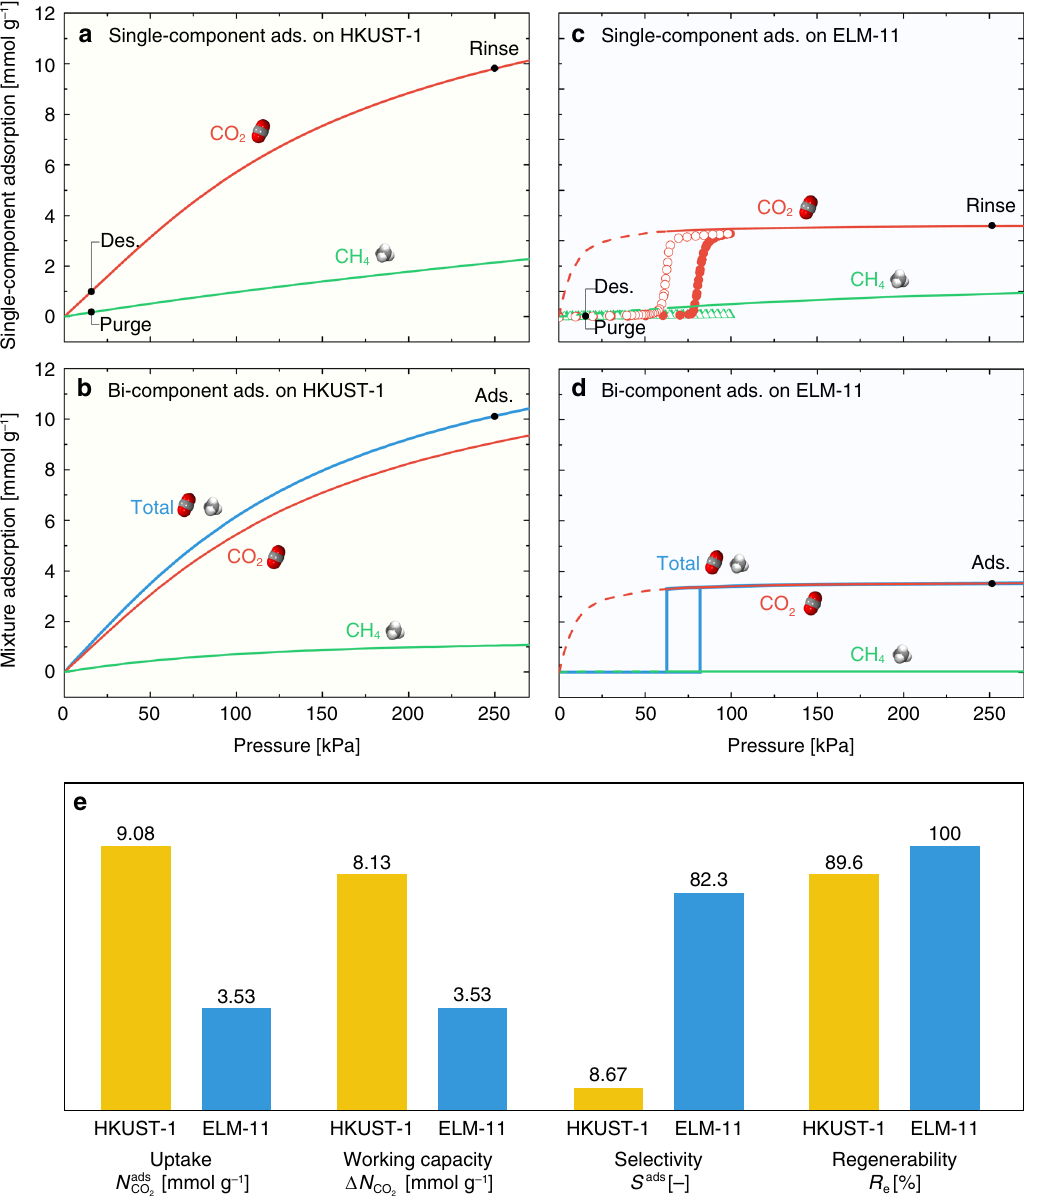
Fig. 3 Adsorption properties of HKUST-1 and ELM-11 under isothermal conditions. Single-component adsorption isotherms of CO 2 and CH 4 at 298 K on a HKUST-1 from the experimentally determined Virial − Langmuir equations 24 and c ELM-11 ( fi lled symbols: experimental adsorption data, open symbols: experimental desorption data, lines: adsorption data simulated by grand canonical Monte Carlo (GCMC)). Total and component adsorption isotherms of an equimolar mixture of CO 2 and CH 4 at 298 K for b HKUST-1 evaluated by the ideal adsorbed solution theory 25 and d ELM-11 simulated by GCMC. The abscissae of b and d correspond to the partial pressures of CO 2 . Black fi lled circles represent the points at which the corresponding pressures were applied in the four elementary steps of the rapid pressure vacuum swing adsorption (PVSA) process. e CO 2 separation characteristics of HKUST-1 and ELM-11 assuming PVSA under isothermal conditions at 298 the adsorbent are equal at point b . This means that the tem- perature of HKUST-1 changes from 298 to 370 K during the adiabatic pressurization and adsorption process. If we perform adiabatic depressurization and rinsing with pure CO 2 at 250 kPa, the state moves to point c (366 K), where the purple line and the green plane intersect. The adiabatic desorption of CO 2 from 250 to 15 kPa results in a signi fi cant decrease in the system tem- perature, as indicated by point d (313 K). Finally, the state moves back to point a on adiabatic purging of CO 2 with a fl ow of a pure CH 4 gas at 15 kPa. The adsorption amounts of CO 2 and CH 4 on HKUST-1 at corresponding points a − d are listed in Table 1.